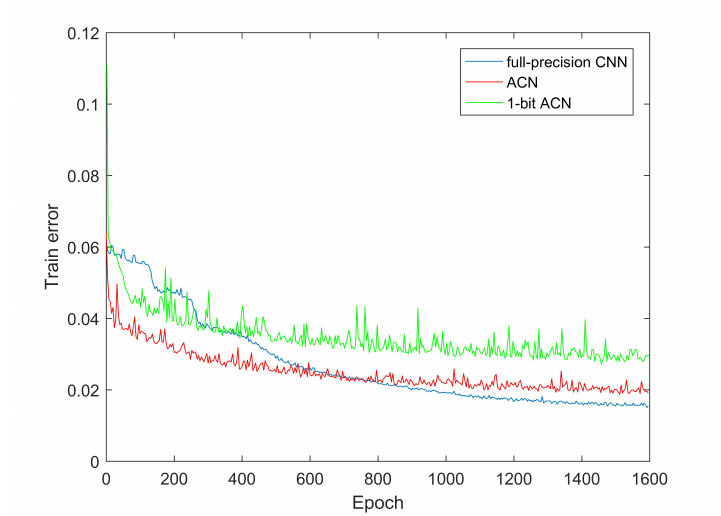
Figure 3. Training error